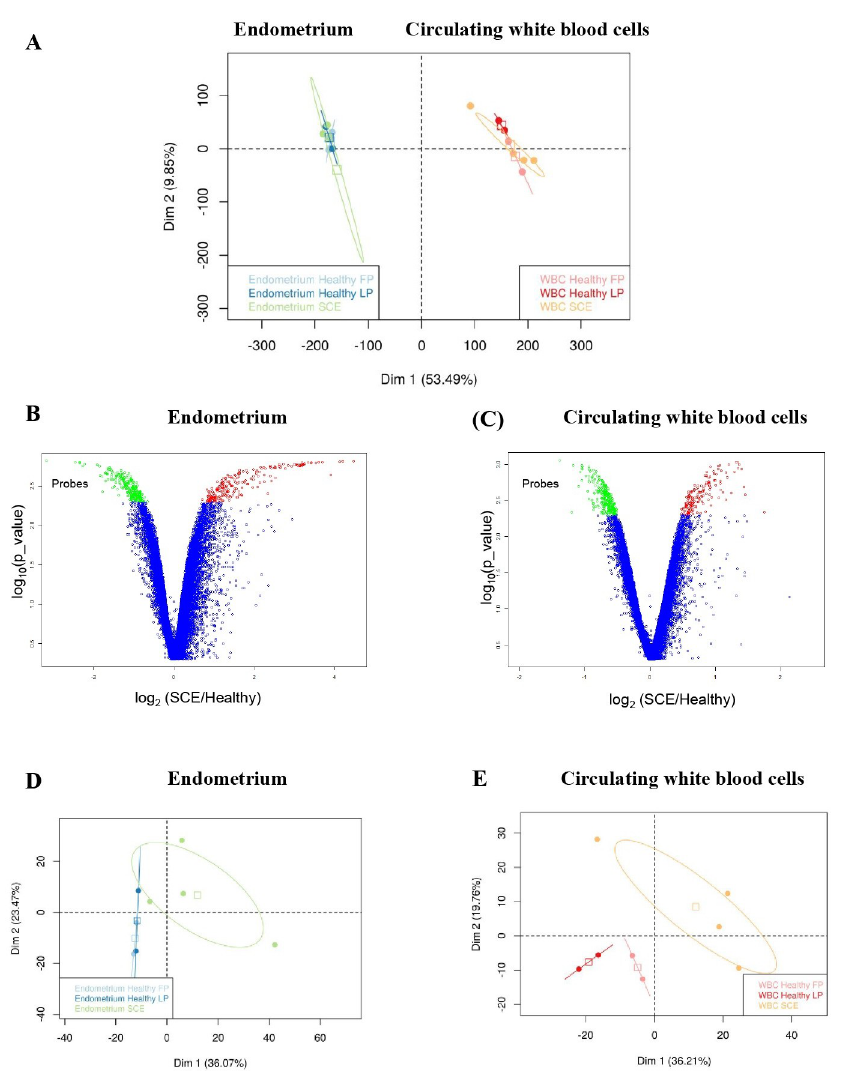
Fig 1. Gene expression profiles for endometrium and circulating white blood cells collected from Holstein dairy cows with subclinical endometritis and from healthy cows. ( A ) Principal component analysis (PCA) plots using all genes (probes) from microarray-based data obtained from endometrium and circulating white blood cells (WBC) collected from the same individuals (dairy Holstein cows) at 45–55 days postpartum (DPP). Plots and cluster distributions on 19,479 gene patterns are presented for endometrial biopsies and circulating white blood cells collected from 4 cows with subclinical endometritis (SCE; follicular phase, n = 1; luteal phase, n = 3) and from 4 healthy cows either in follicular phase (FP; n = 2) or in luteal phase (LP; n = 2). All SCE females were gathered in a unique group. The PCA score plots showed segregation between endometrium and WBC. Endometrial samples from SCE cows, healthy LP cows and healthy FP cows are indicated in green, dark blue and light blue color respectively. Circulating white blood cells (WBC) from SCE cows, healthy LP cows and healthy FP cows are indicated in orange, red and pink color respectively. ( B, C) Volcano plot analyses were used to show the differentially expressed genes in endometrium and in circulating white blood cells from cows with subclinical endometritis (SCE, n = 4) compared with healthy (n = 4) Holstein dairy cows at 45–55 days postpartum (DPP) respectively. The x-axis represents the log2 of the fold change (FC), which was plotted against the − log10 of the p-value. The p-value is equal to the f.value for down regulated genes or 1-f.value for up-regulated genes. The f.value thresholds 0,005 and 0,995 were used for down- or up-regulated genes (in green and red respectively). These threshold values lead to a selection error equal to 1%. ( D, E ) Principal component analysis (PCA) plot using differentially expressed genes (DEGs) identified in endometrium and circulating white blood cells from 4 Holstein dairy cows with subclinical endometritis (SCE) compared with 4 healthy Holstein dairy cows in luteal phase (LP; n = 2) or in follicular phase (FP; n = 2) at 45–55 days postpartum (DPP). ( D ) Endometrial biopsies from SCE cows (n = 4), healthy LP cows (n = 2) and healthy FP cows (n = 2) are indicated in green, dark blue and light blue color respectively. ( E ) Circulating white blood cells (WBC) from SCE cows (n = 4), healthy LP cows (n = 2) and healthy FP cows (n = 2) are indicated in orange, red and pink color respectively.